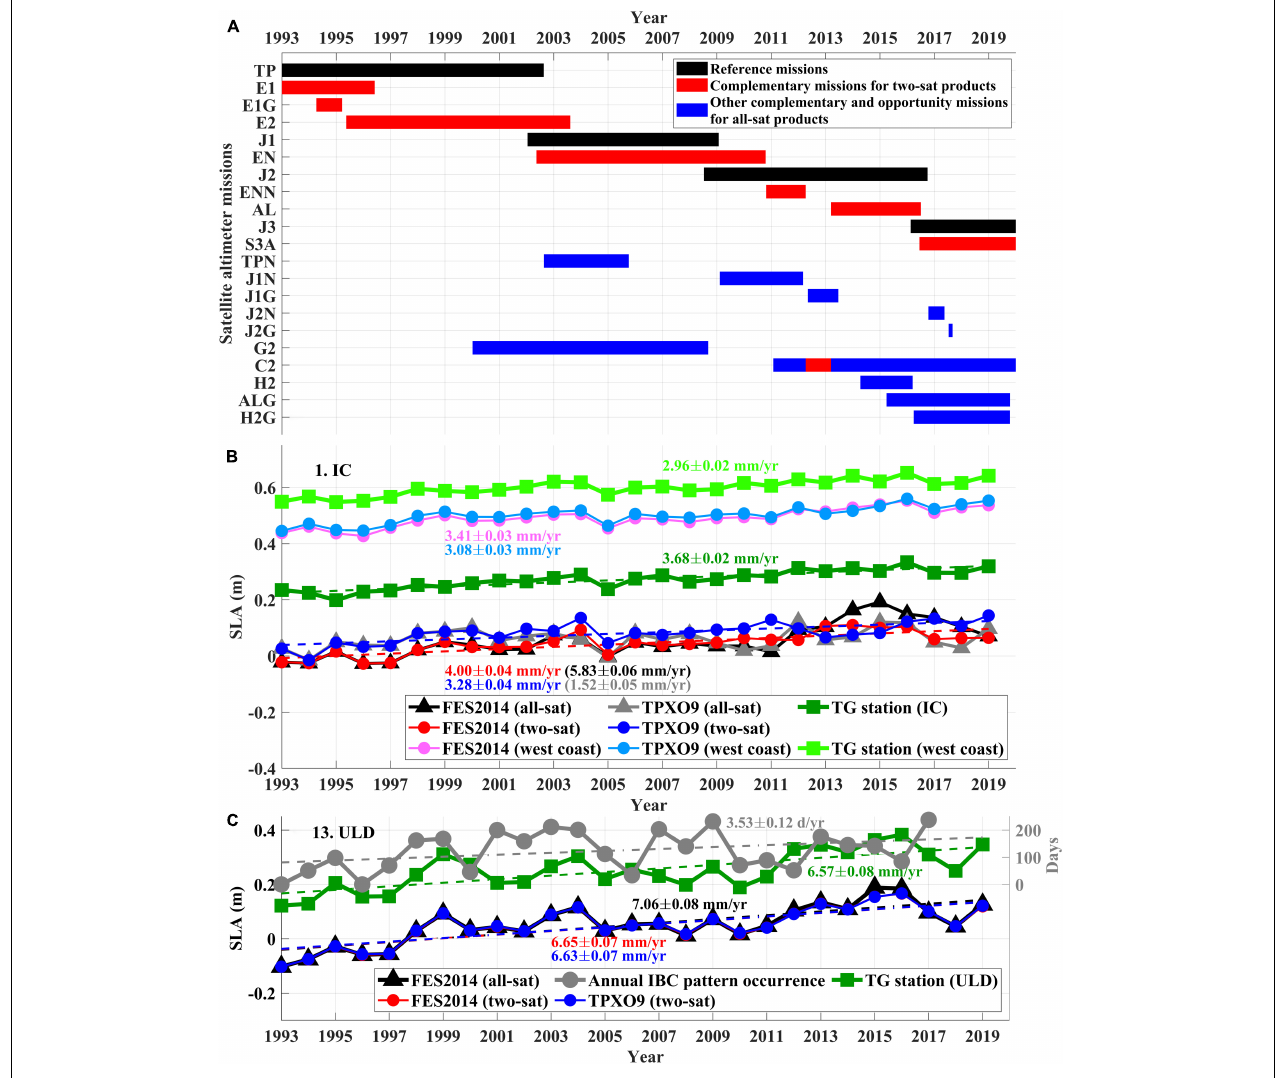
FIGURE 2 | (A) Timeline of operational satellite altimetry missions for two-sat (black and red) and all-sat (black, red, and blue) merged gridded sea level products. Time series are shown for annual mean SLA TG (green), SLA FES 2014 (black and red), and SLA TPXO 9 (gray and blue) nearby TG stations of (B) IC and (C) ULD, for two-sat (red and blue) and all-sat (black and gray) missions. For two-sat missions, Annual mean SLA TG averaged over four TG stations (IC, BR, GS, MP) on the west coast (light green) and SLA FES 2014 (pink) and SLA TPXO 9 (sky blue) averaged over the western coastal area (marked with red shading in Figure 1 ) are superimposed in (B) . In (C) , red lines are not visible as they are identical to blue lines; annual occurrence days of Inertial Boundary Current (IBC) pattern are also shown (gray line, right y-axis). Numbers in colors corresponding to dashed lines denote LTSLR.